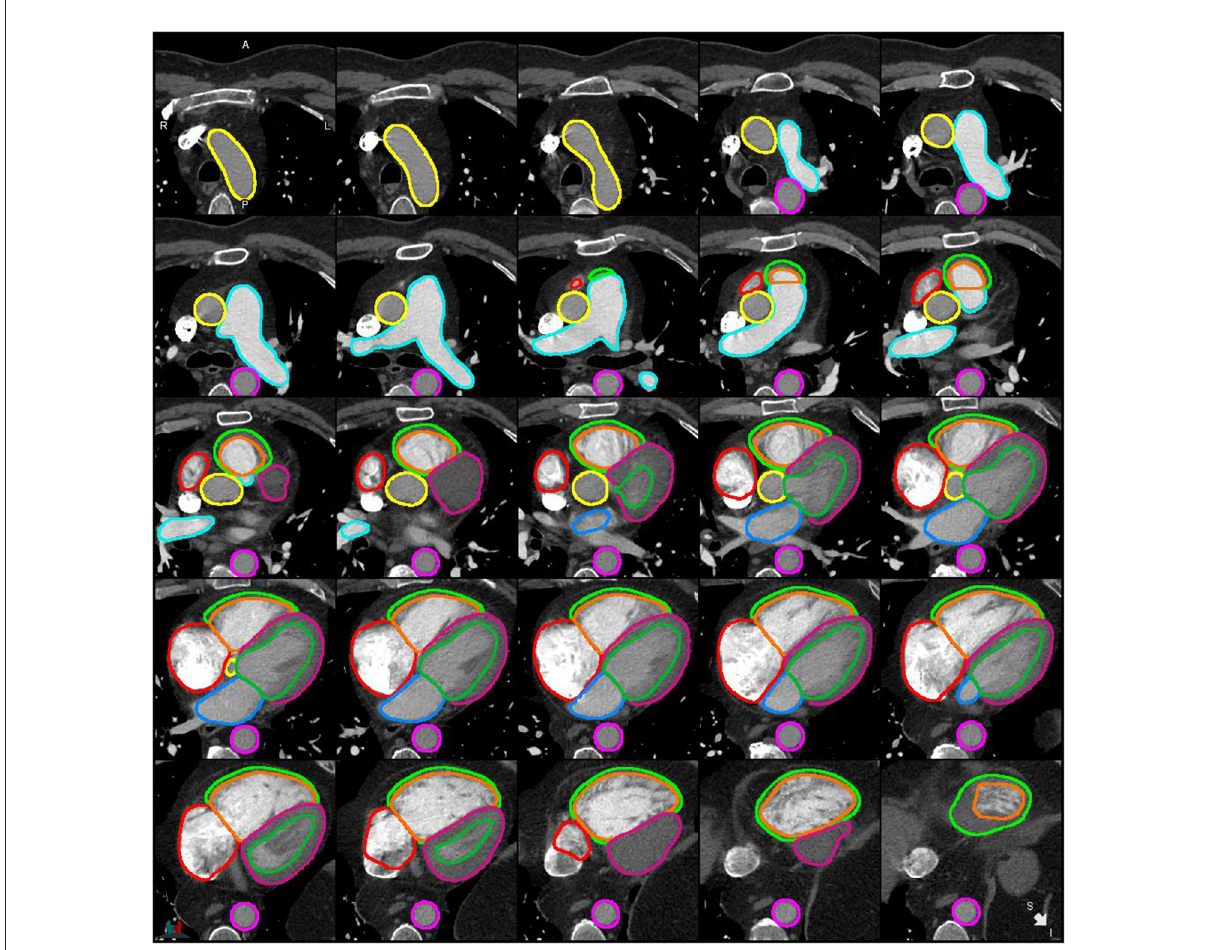
FIGURE4 Example of a successful segmentation by DL-2 for a patient with suspected PH in the internal test cohort.